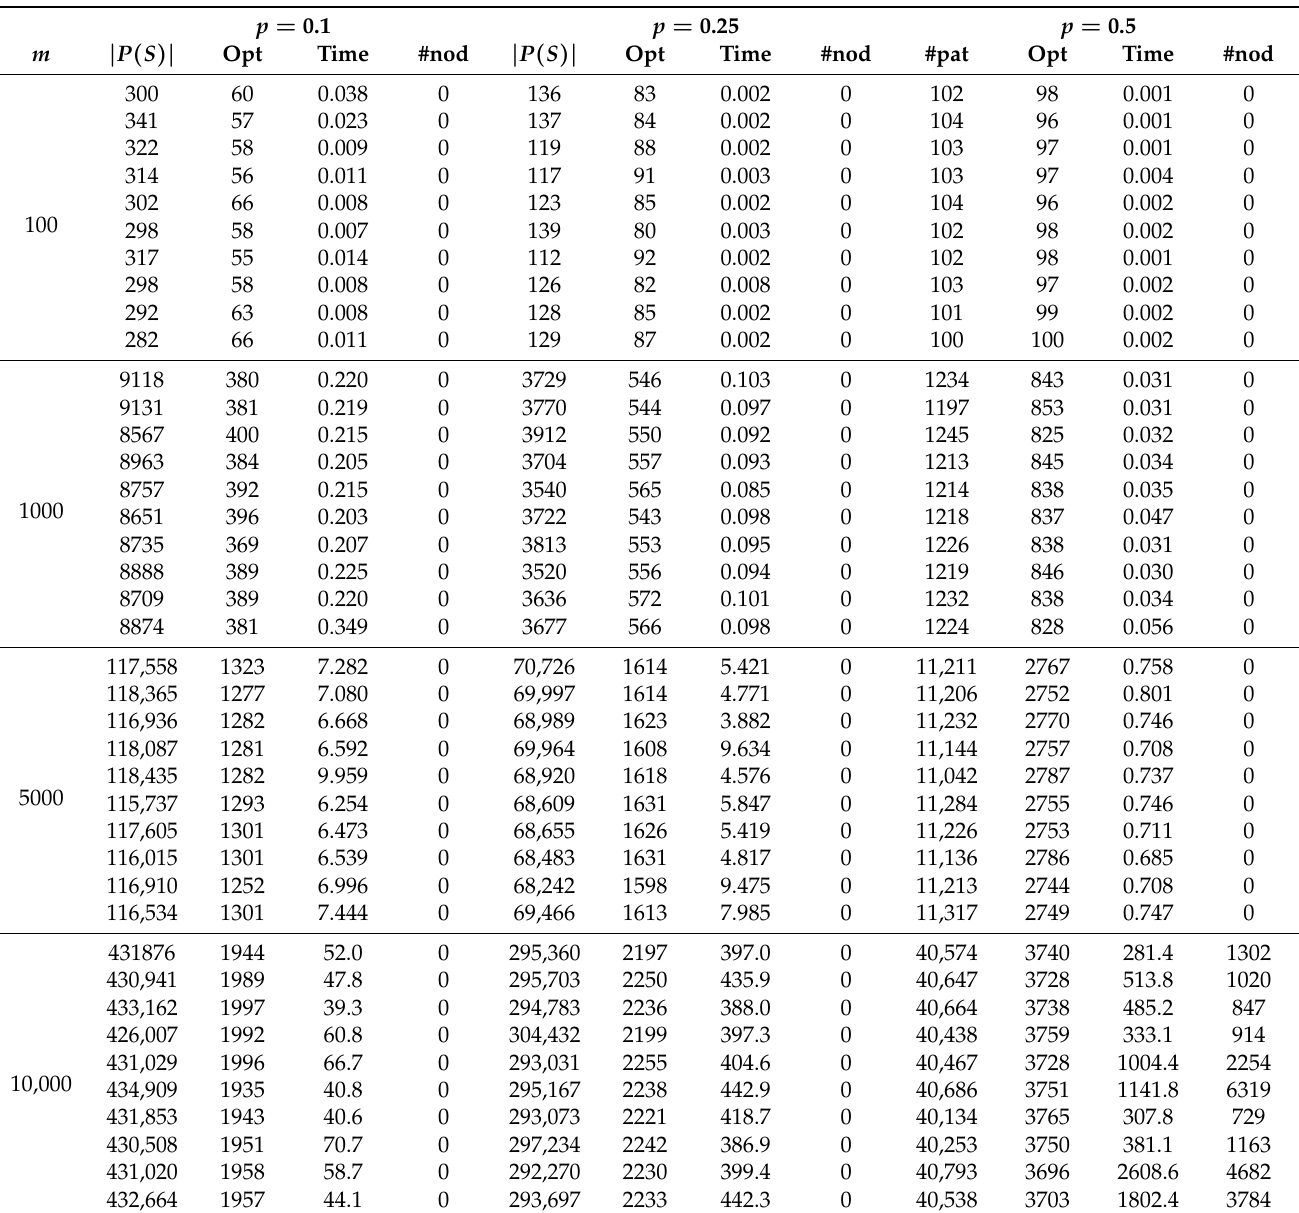
Table 1. Results for Pattern Cover